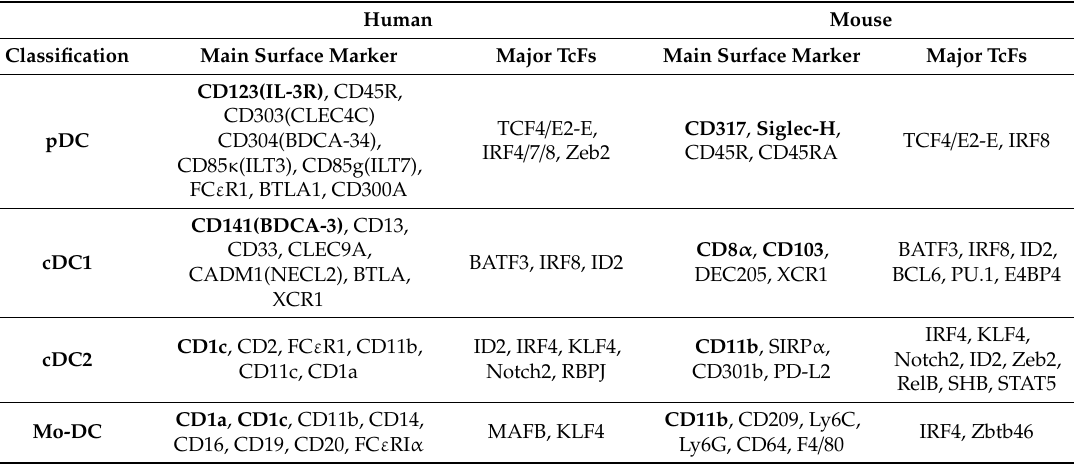
Table 1. Dendritic cell subtypes in the human and